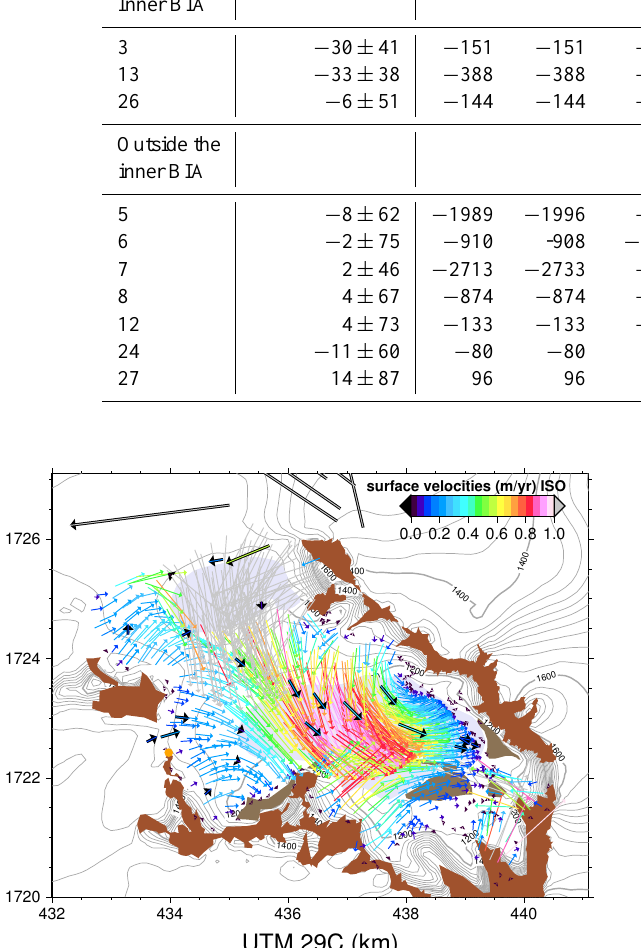
Fig. 4. Horizontal velocity distribution (scale bar) obtained with the isotropic Glen’s flow law compared with measured velocities (thick arrows; see Table 2 for values). Discrepancies in both direction and magnitude (with observed velocities being almost an order of mag- nitude smaller) can be easily